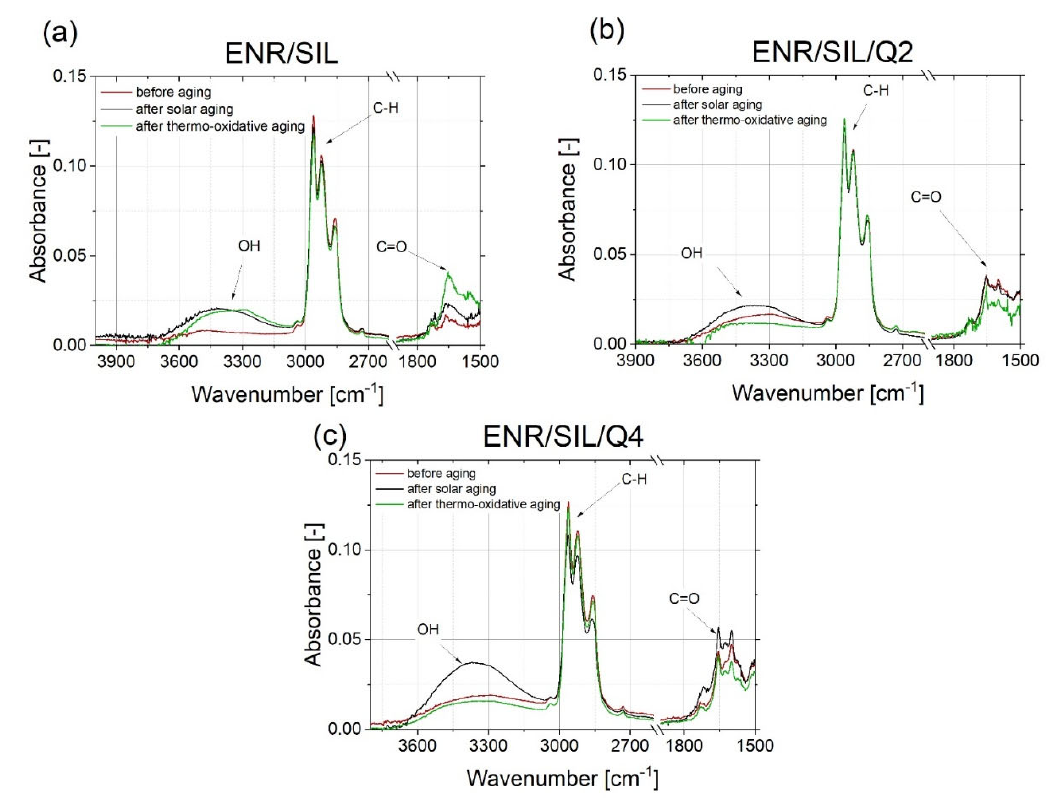
Figure 7. FT ‐ IR spectra of ENR with silica ( a ), ENR cured with combination 2 phr of quercetin and silica ( b ), ENR cured with 4 phr of quercetin and silica ( c ) before and after solar as well as thermo ‐ oxidative aging.